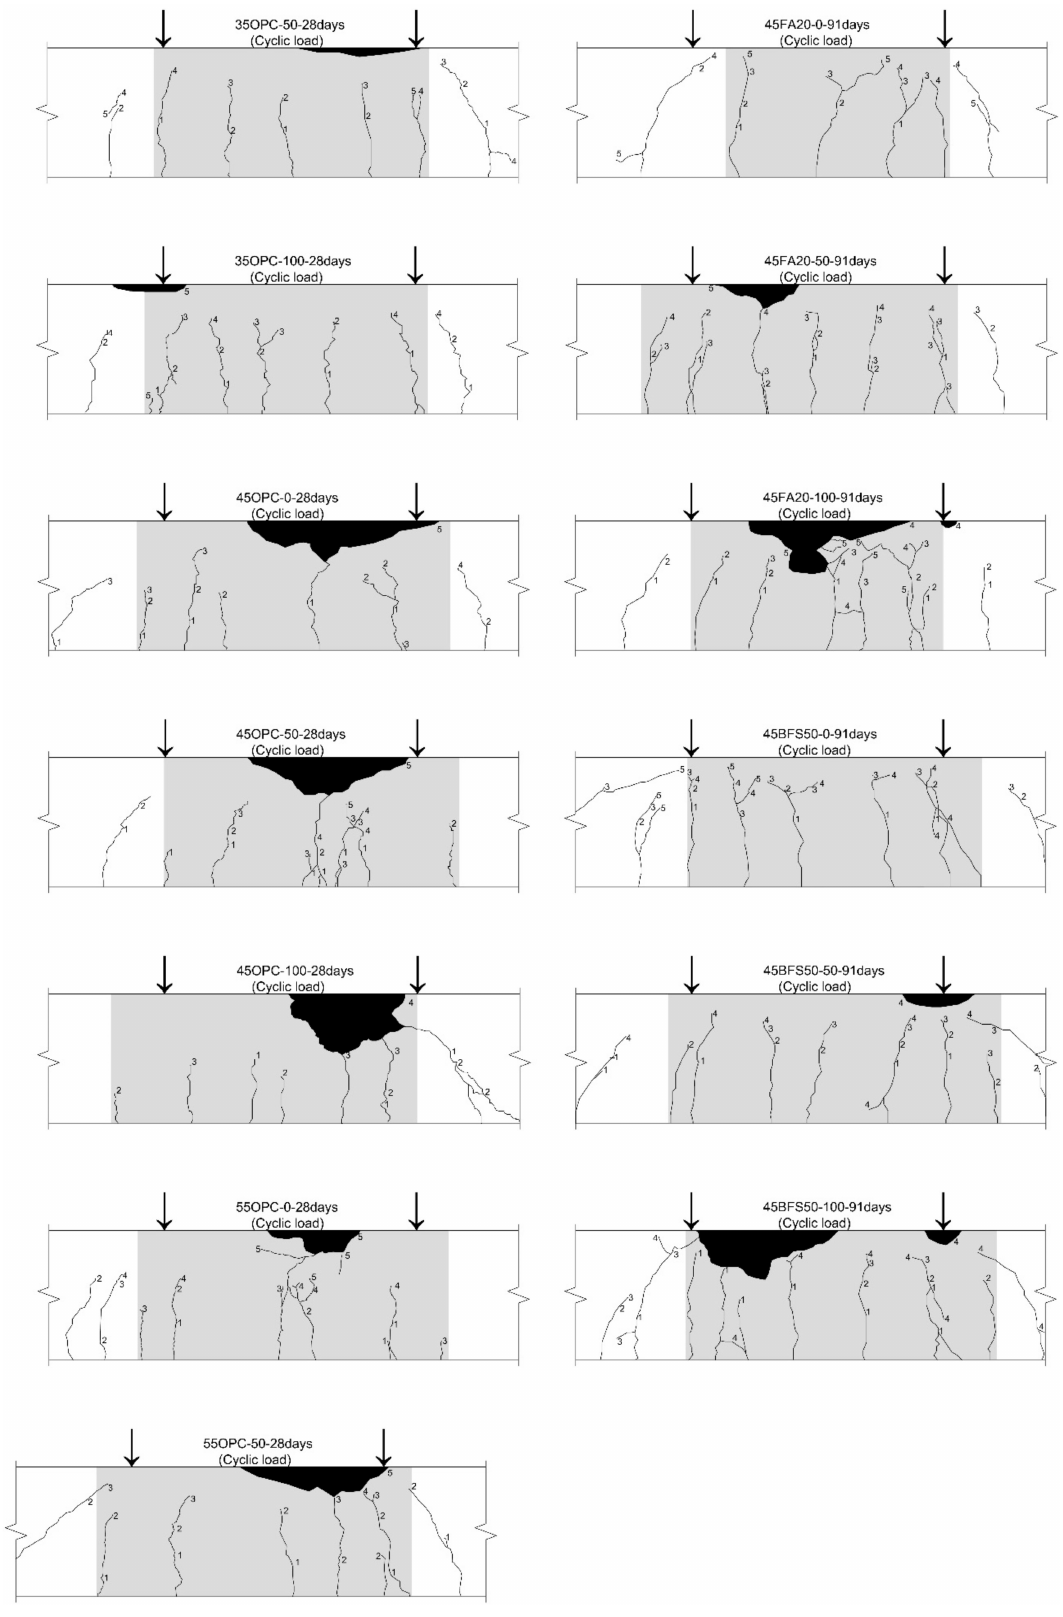
Figure 4. Typical crack occurrence